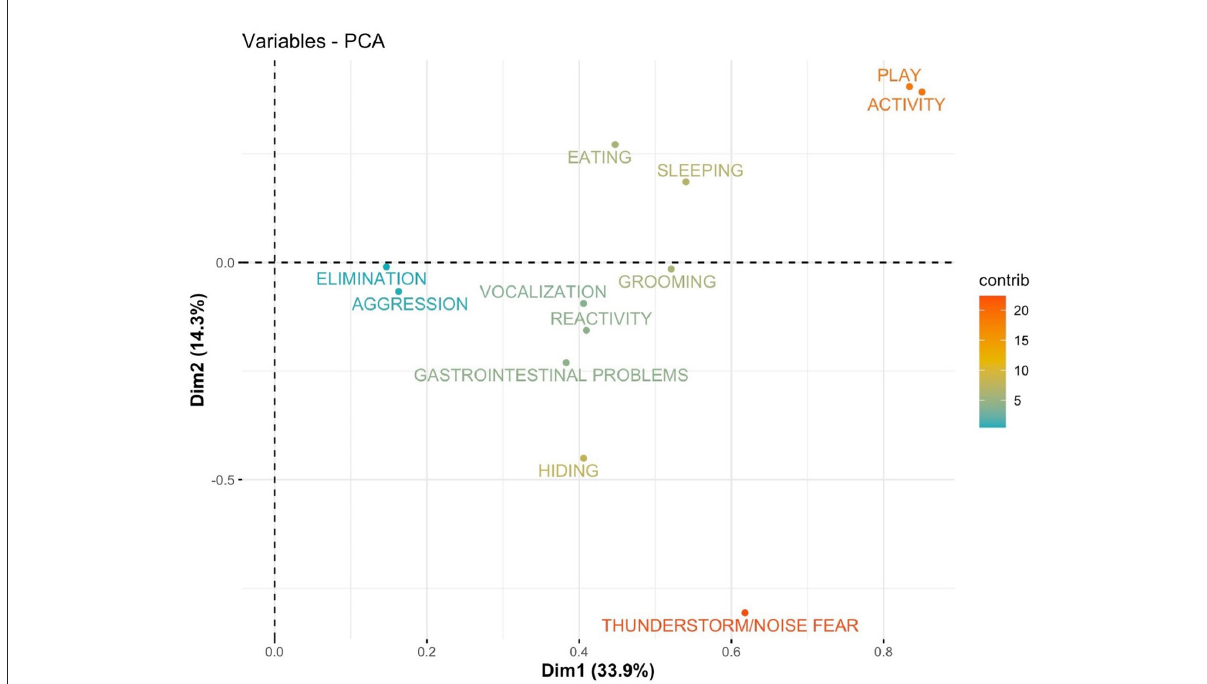
FIGURE2 Loadings plot of the behavioral variables of dogs on the first (PC 1) and second (PC 2) principal components with the increase in temperature. The contribution of the variables is colored depending on their importance.